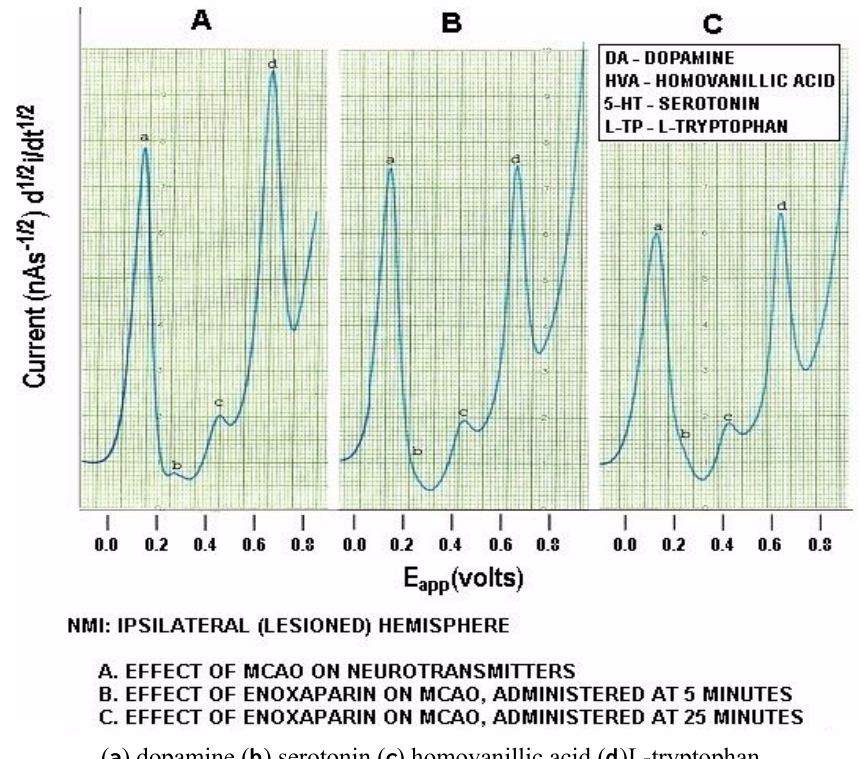
Figure 6. Original data of NMI after middle cerebral artery occlusion (MCAO): enoxaparin therapy, NMI from ipsilateral